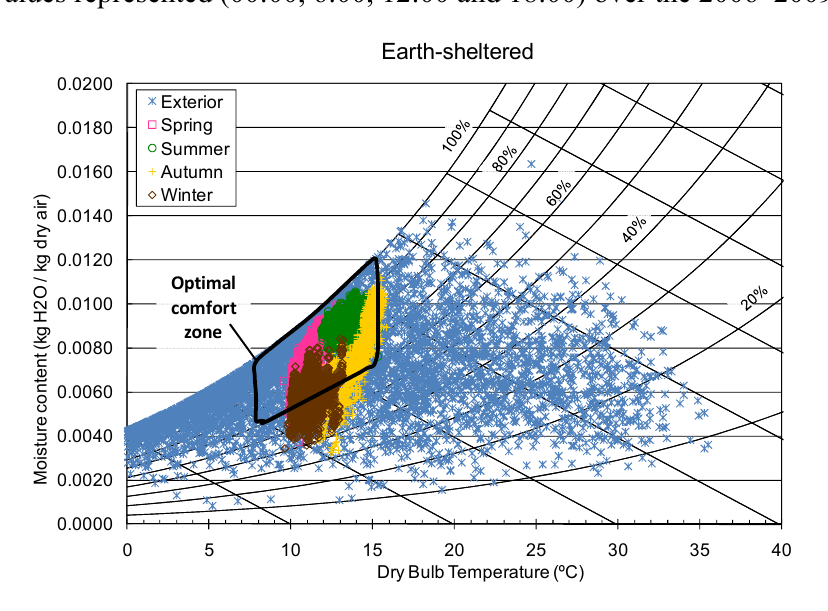
Figure 5. Indoor and outdoor hygrothermal conditions of the earth-sheltered